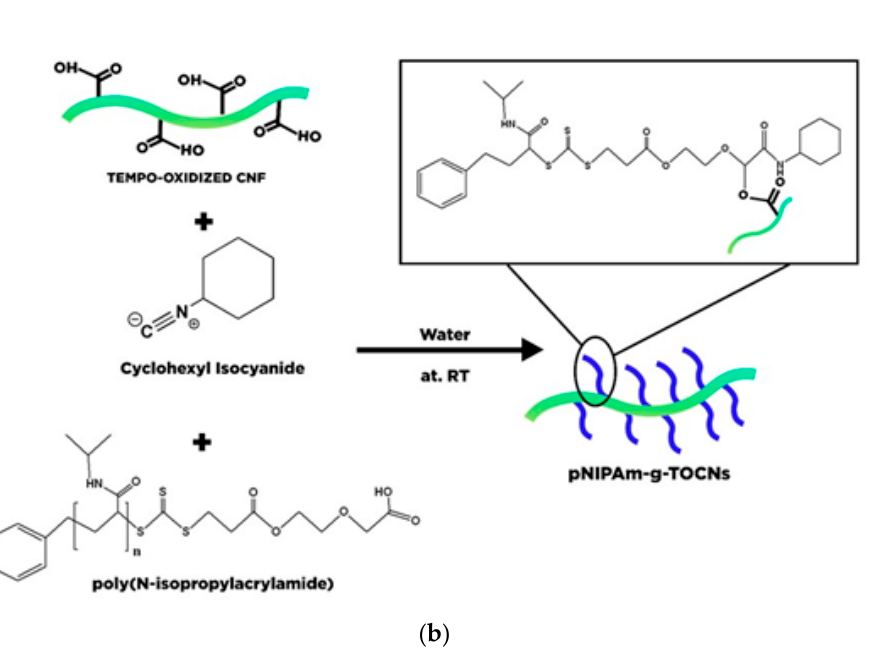
Figure 8. Schematic representation of the polymer grafting technique ( a ). CuAAC “click” reaction for NCC-gPEEP synthesis (this picture is redrawn from Wang et al. [162], Copyright 2010 Royal Society of Chemistry); ( b ) polymer-grafted cellulose fibrils (pNIPAm-g-TOCNs) via Passerini one-pot reaction (this figure is redrawn from Khine et al. [164]. Copyright © 2018 American Chemical Society).